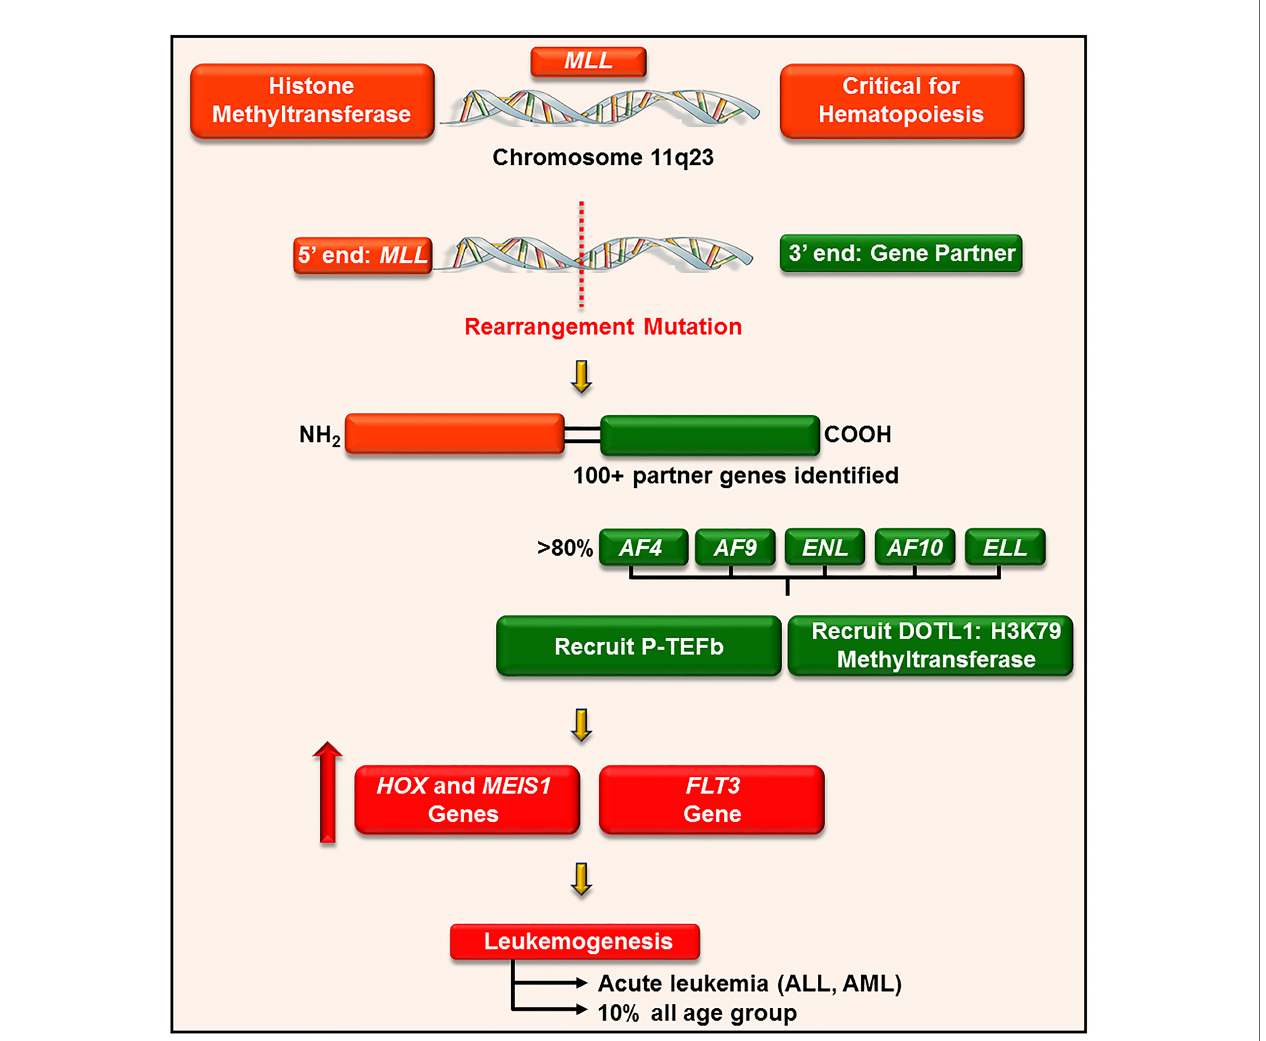
FIGURE 9 | P-TEFb is required for the MLL transcription program and leukemogenesis. MLL is a histone methyltransferase ubiquitously expressed in hematopoietic progenitor cells and plays a key role in their self-renewal. For unknown reasons, MLL gene (on chromosome 11q23) undergoes a trans-locational mutation where